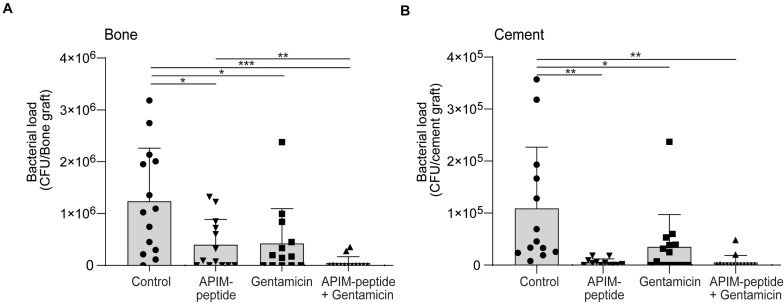
Antibacterial effect of APIM-peptide and gentamicin in an in vivo bone graft model. MRSE growth in infected bone grafts filled with bone cement containing APIM-peptide, gentamicin, and a combination of gentamicin and APIM-peptide or water (control). Bone grafts were infected (103 CFU inoculum), inserted intramuscularly in rats (2 per animal), and retrieved after 4 days. The bone graft and the cement pieces inside were removed and bacterial load was quantified separately in bone and cement. Student two tailed-paired t-test, only statistically significant differences are depicted in the figure, *p < 0.05, **p < 0.01, ***p < 0.001. (A) CFU count of the bone grafts. (B) CFU count of the bone cement pieces.